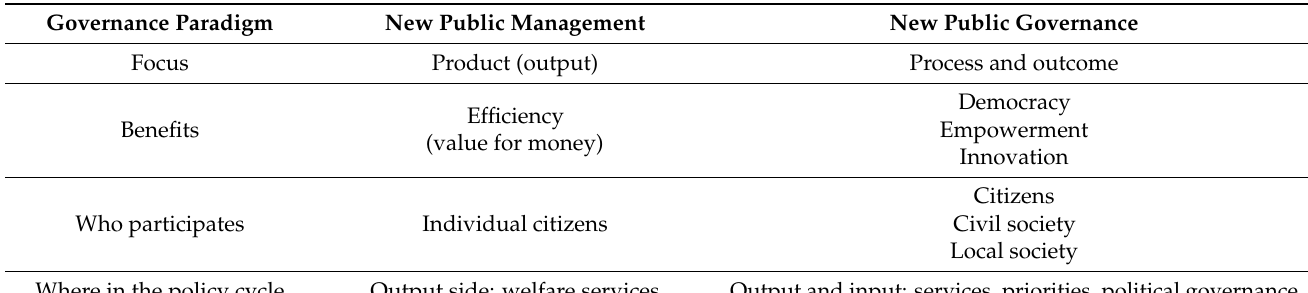
Table 1. Views on co-creation according to Agger and Tortzen